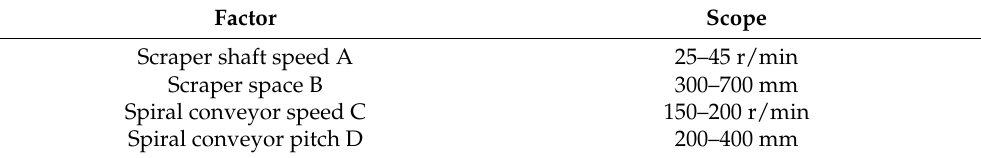
Table 2. Key factors and